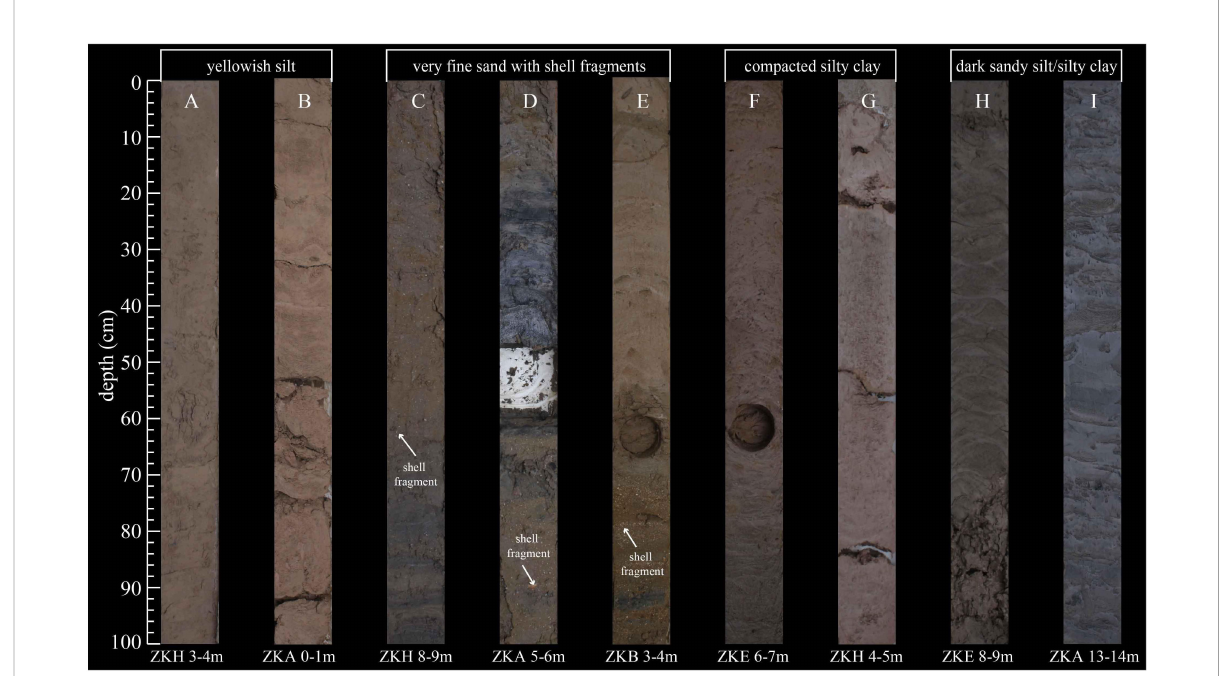
FIGURE 2 Photographs of representative sedimentary facies of the drilling cores. (A, B) delta plain; (C – E) beach ridge; (F, G) abandoned delta plain; (H, I) delta front. The circles in the ZKB 3-4 m (E) and ZKE 5-7 m (F) are the sampling position of OSL